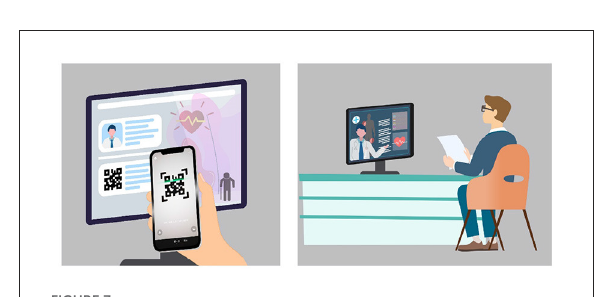
FIGURE7 Remote training and teaching for CMEC services.